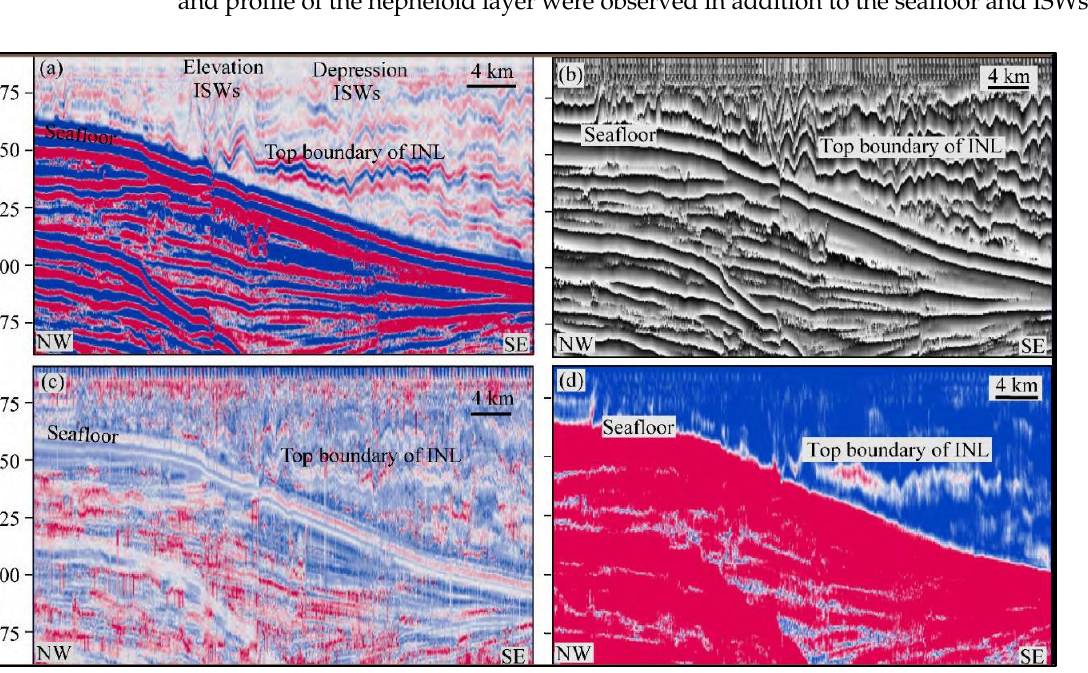
Figure 8. The seismic oceanography ( a ), instantaneous phase ( b ), frequency ( c ), and amplitude ( d ) profiles of the intermediate nepheloid layer [94]. ISW: internal solitary wave.